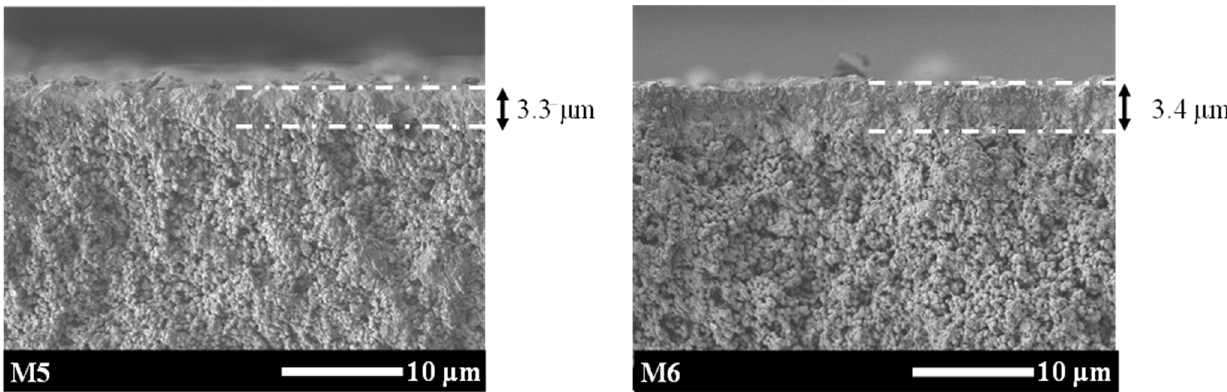
Table 3. Equimolar CO 2 /CH 4 mixture separation performances of all-silica ZSM-58 zeolite